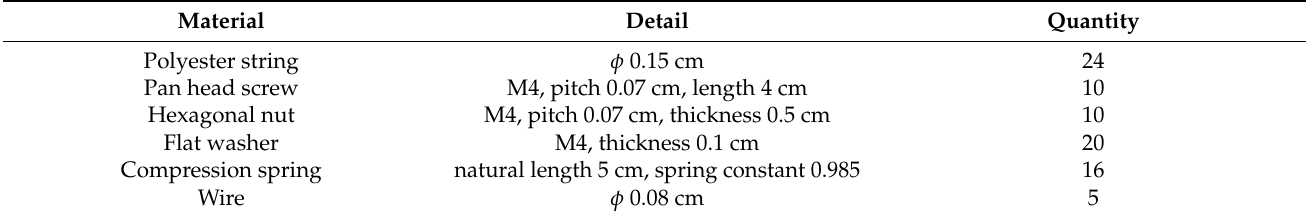
Table 2. The materials other than the sticks for the developed arm.